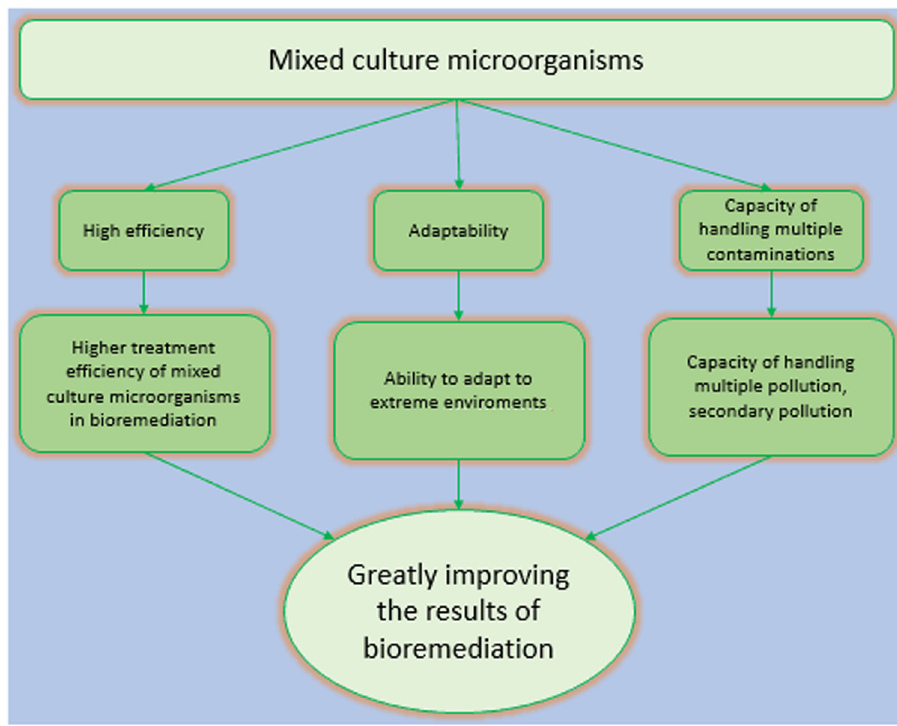
Figure 1: Advantages of mixed culture in bioremediation compared to pure